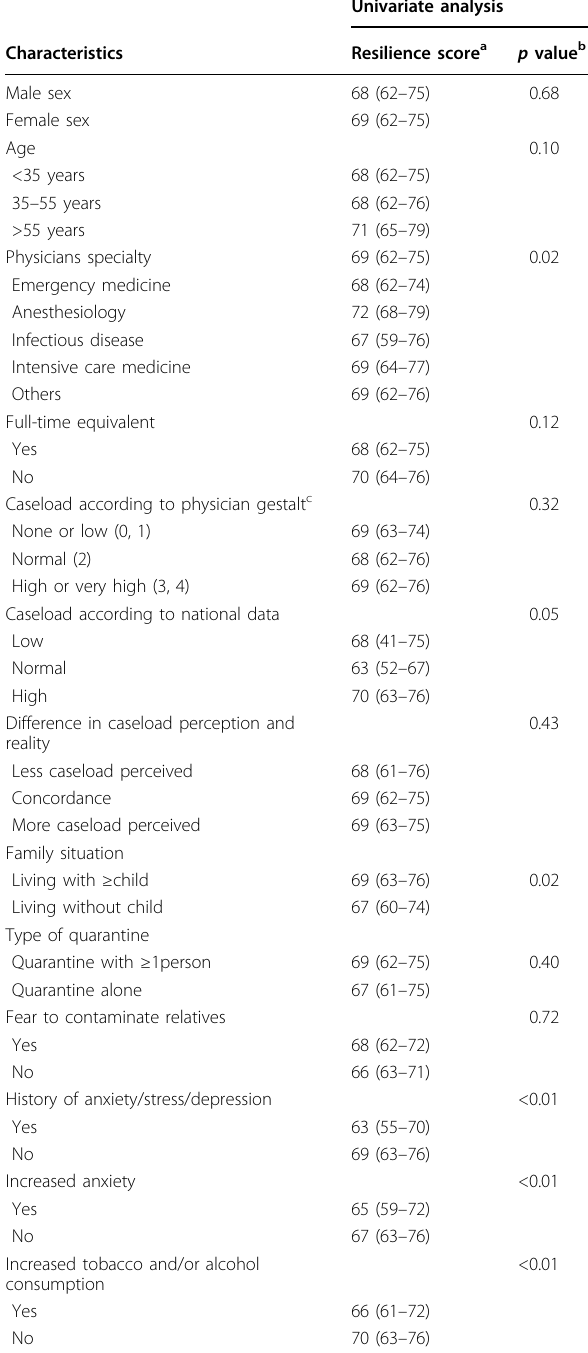
Table 2 Classi fi cation of levels of resilience measured by CD-RISC 25 grouped by a range of